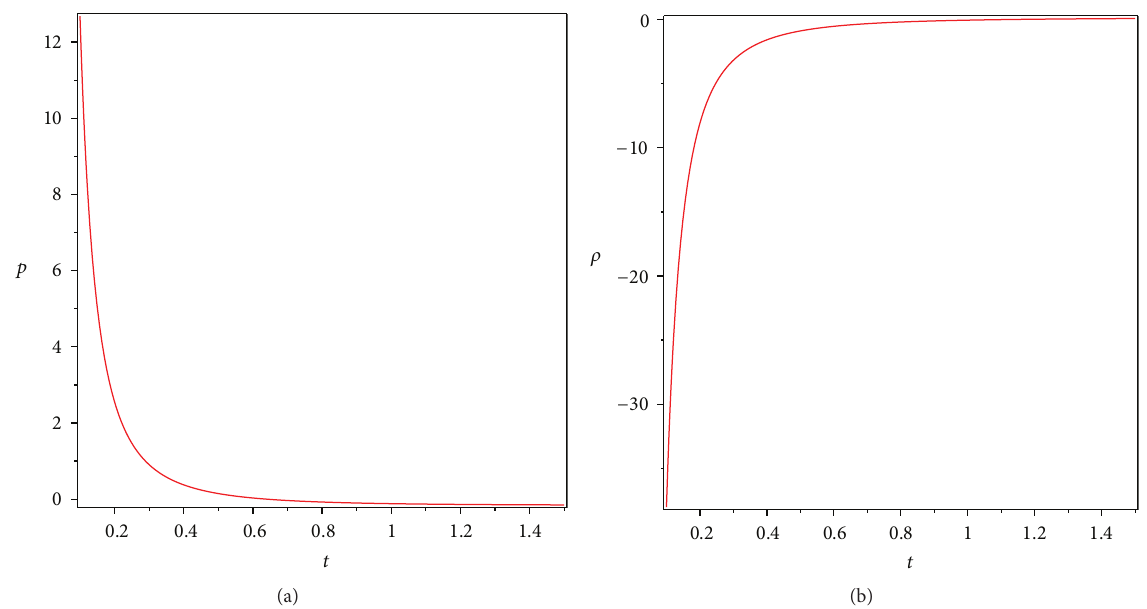
Figure 4: Variation of pressure (a) and energy density (b) with respect to time for a nonminimal coupling model (where 𝜉 = 0.14